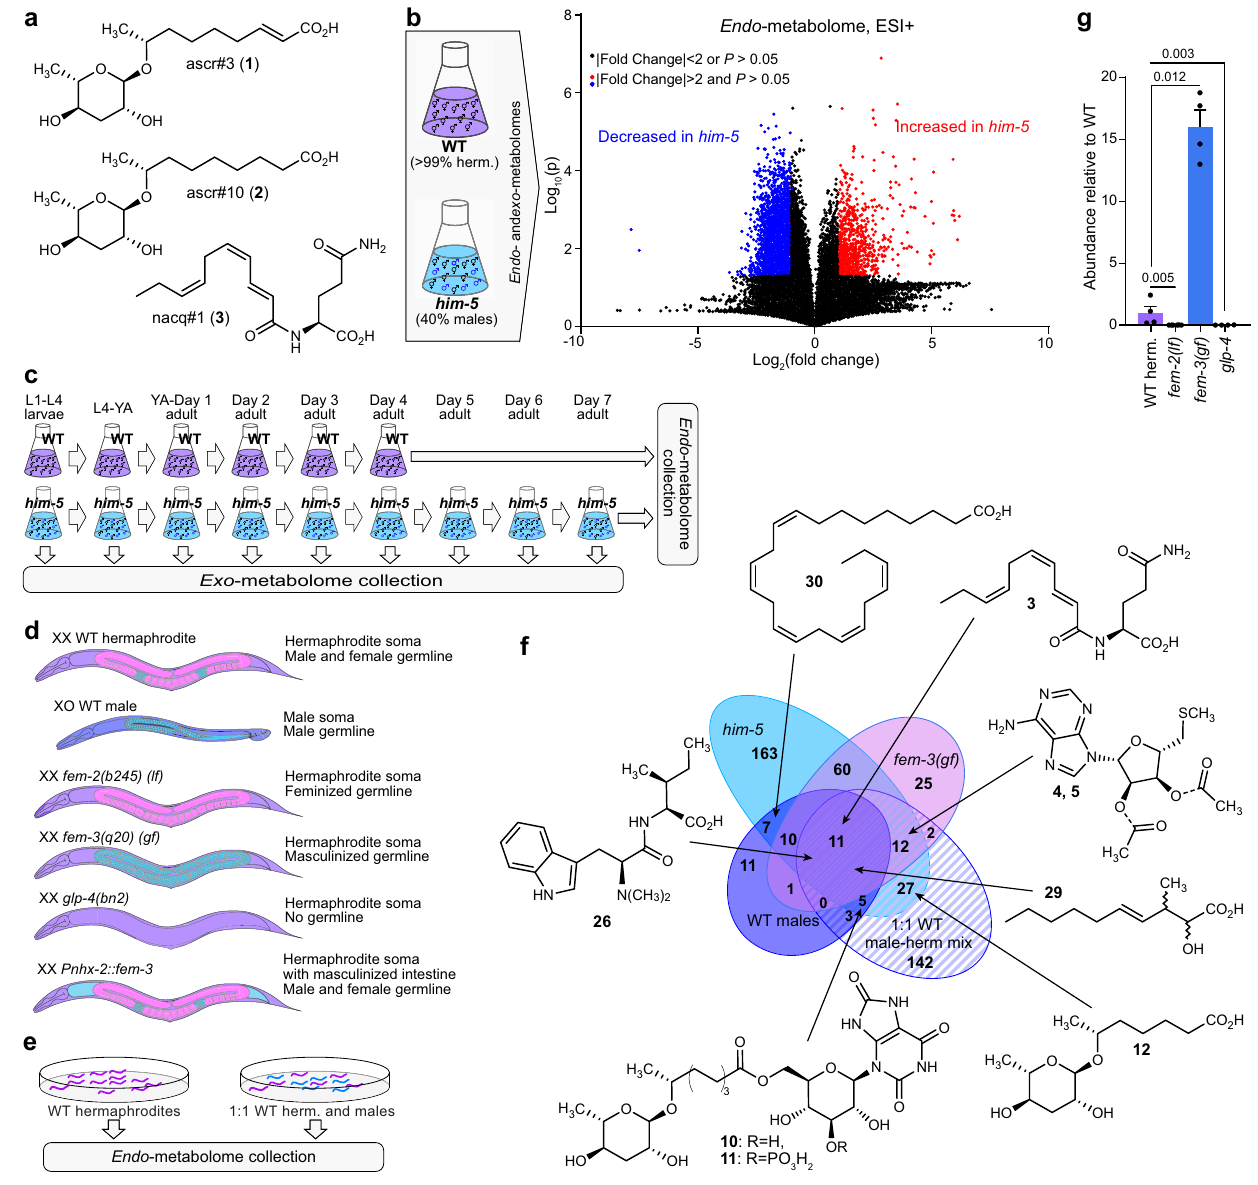
Fig. 1 | Metabolomic pro fi ling ofmale C.elegans . a Previouslycharacterized sex- biased metabolites in C. elegans . Whereas ascr#3 ( 1 ) is more abundant in her- maphrodites, ascr#10 ( 2 ) and nacq#1 ( 3 ) are more abundant in males. b Comparison of the metabolomes of WT and male-enriched him-5(e1490) mutants.ThevolcanoplotshowsthesubsetoffeaturesdetectedbyHPLC-HRMSin positiveionizationmode(ESI+),highlightingfeaturesincreased(red)ordecreased (blue) in him-5 relative to WT endo -metabolome extracts. P values werecalculated via unpaired two-sided t tests; see “ Metaboseek analysis ” , for details. c Experimental setup for monitoring metabolism of WT and him-5 animals with periodic harvesting of the exo- metabolome; YA young adults. d Simpli fi ed body plans of WT hermaphrodites and WT males as well as germline-feminized fem- 2(b245) (lf) , germline-masculinized fem-3(q20) (gf) , germline-de fi cient glp-4(bn2) ,